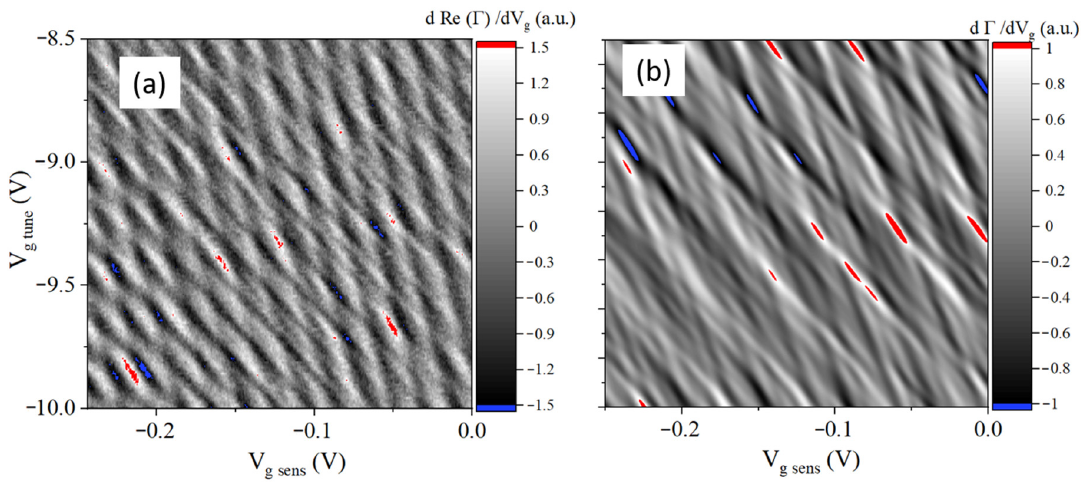
Figure 15. ( a ) Experimentally acquired two–dimensional map of derivative dRe( Γ ) / dV g from a 15 source-coupled 200 SEB array at 0.3 K; ( b ) simulated response of an array of 200 SEB composed of two 100 SEB subarrays with di ff erent coupling to tuning gate. C g sense = 3 aF with 1% STD (horizontal axis, V g sens ) and C g tune 1 = 0.2 aF STD 10%, C g tune 2 = 0.4 aF STD 10% (vertical axis, V g tune ). The contribution of each SEB to the signal is assumed to be equal. The development of the moire pattern is clearly visible. Red (blue) regions correspond to the maxima (minima) of the